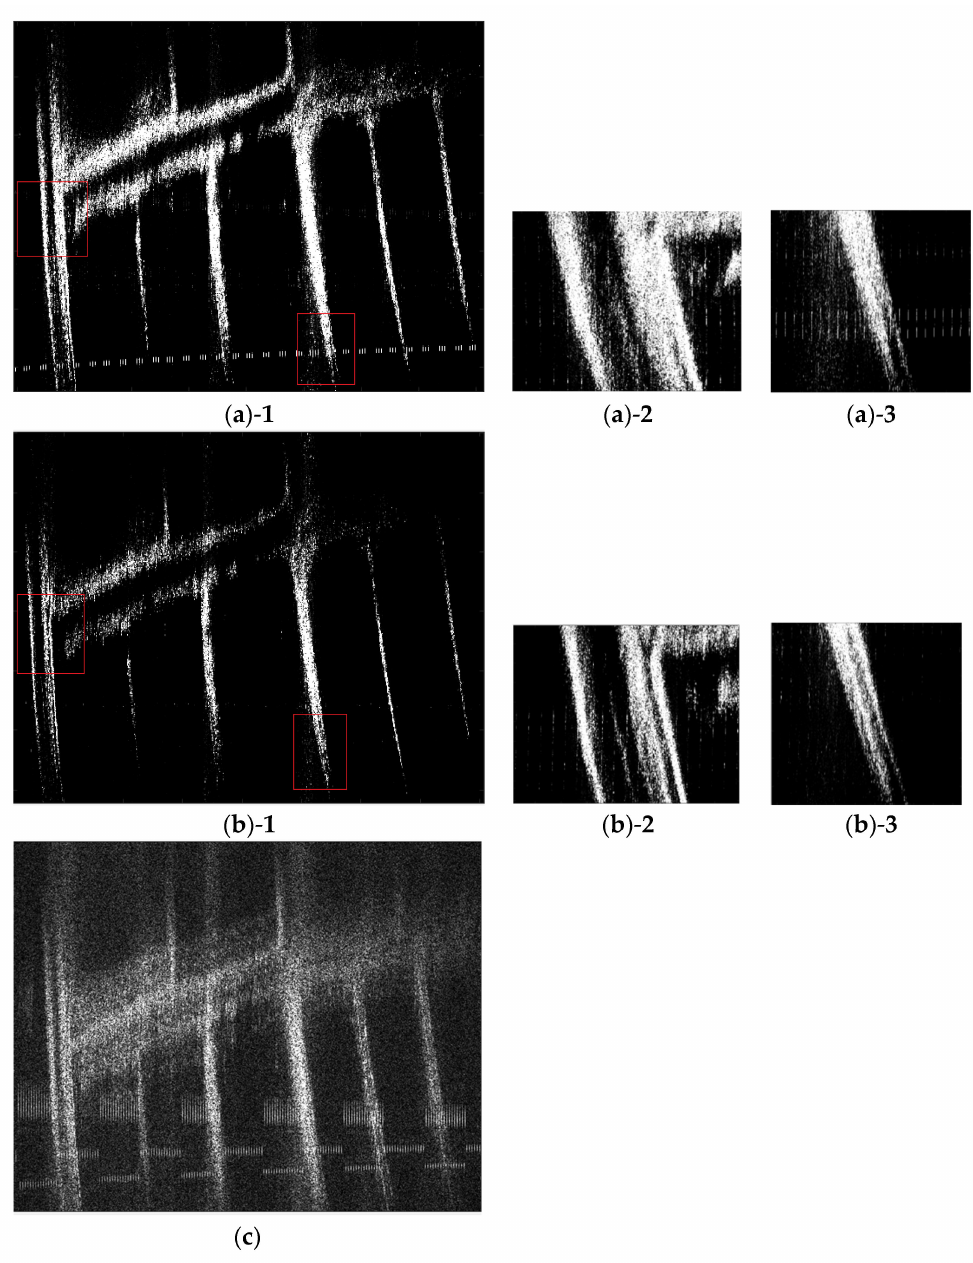
Figure 11. Imaging results of each algorithm with an undersampling rate of 0.7: ( a ) Algorithm 1, ( b ) Algorithm 2, ( c ) Direct